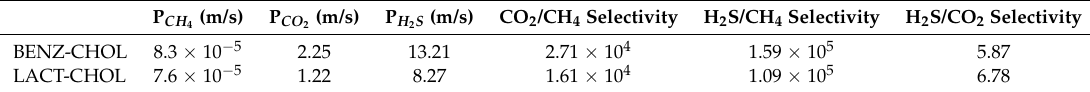
Table 1. Permeability coefficients of CH 4 , CO 2 and H 2 S in choline-benzoate and choline-lactate ILs. The last three columns show the CO 2 /CH 4 , H 2 S/CH 4 and H 2 S/CO 2 selectivities of the considered ionic liquids defined as the ratios of the permeability